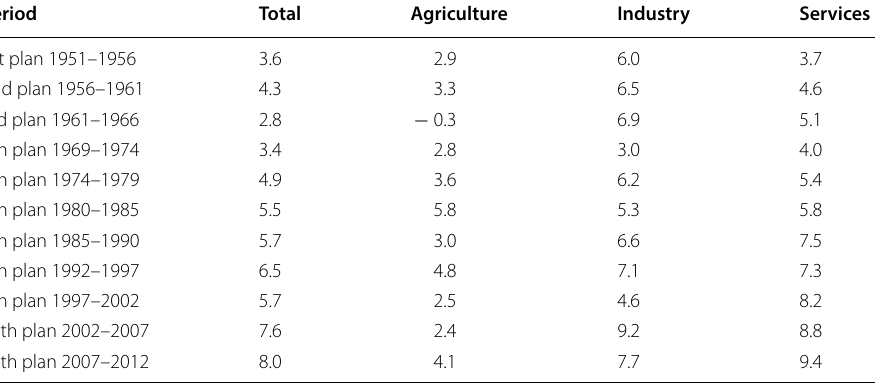
Table 1 Sector wise growth in India (y–o–y growth). Source: Authors’ calculations based on Data from Ministry of Statistics and Program Implementation, Government of India